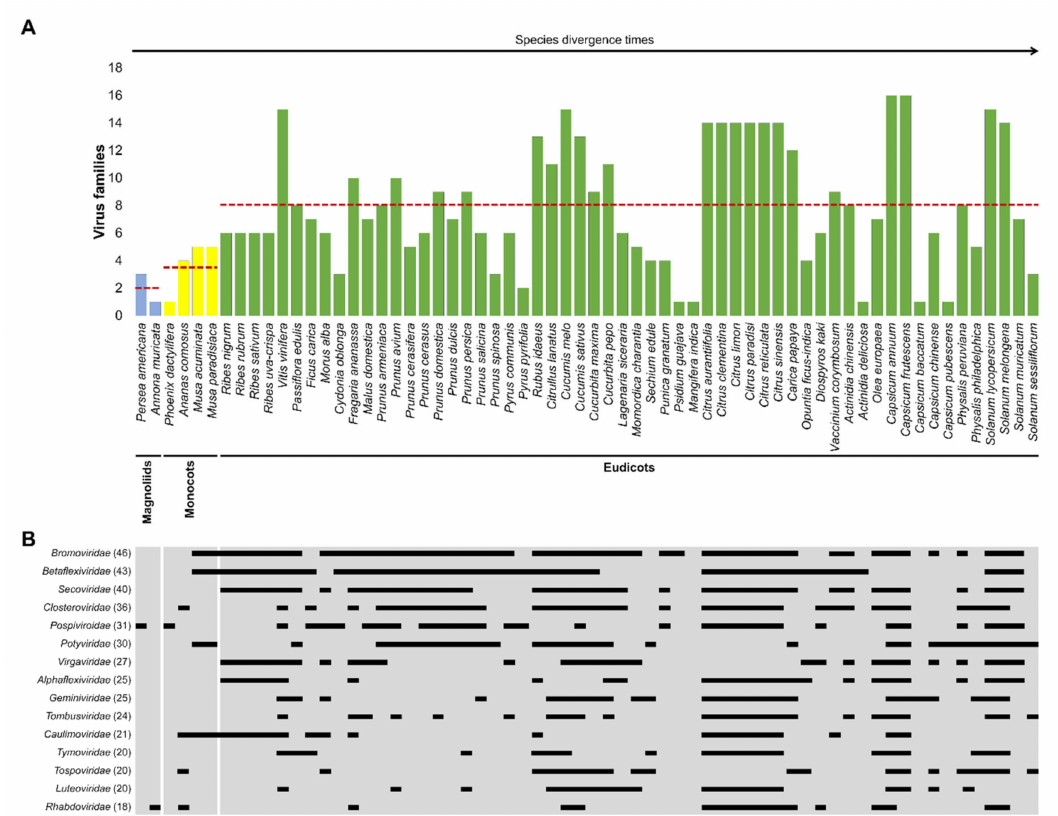
Figure 4. Virus families infecting the 64 commercially important EFFs. of EFFs according to plant divergence times [93], and references therein], as well as the number of virus families infecting them. The average number of virus families infecting EFFs classified into magnoliids, monocots, and eudicots is indicated with a red dashed line. ( B ) The host range for the first 15 virus families is exemplified with thin rectangles (filled). Complete information is found in Supplementary Table